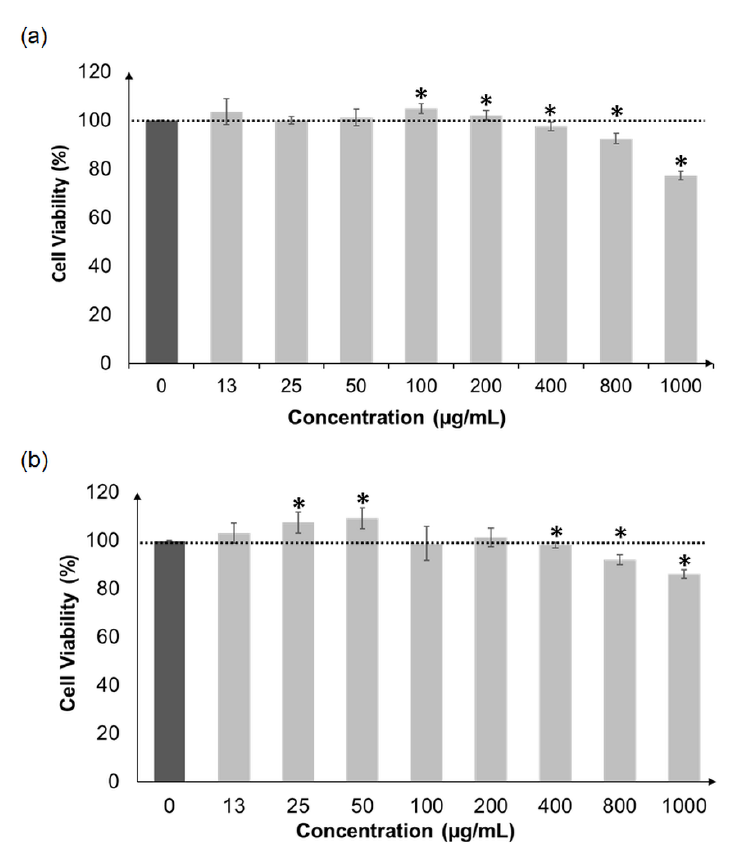
Figure 2. Cellular viability of HepG2 cells after pre-treatment with CNL ( a ) and CNS ( b ) at various concentrations (13 to 1000 µ g/mL). All measurements were performed in triplicate and are expressed as mean ± standard deviation. Data were analyzed by comparing samples of different concentrations with untreated controls (100% viability) using the unpaired sample t -test. Values with the symbol * are significantly different at p < 0.05. (CNL: Clinacanthus nutans leaf extract; CNS: Clinacanthus nutans stem extract).